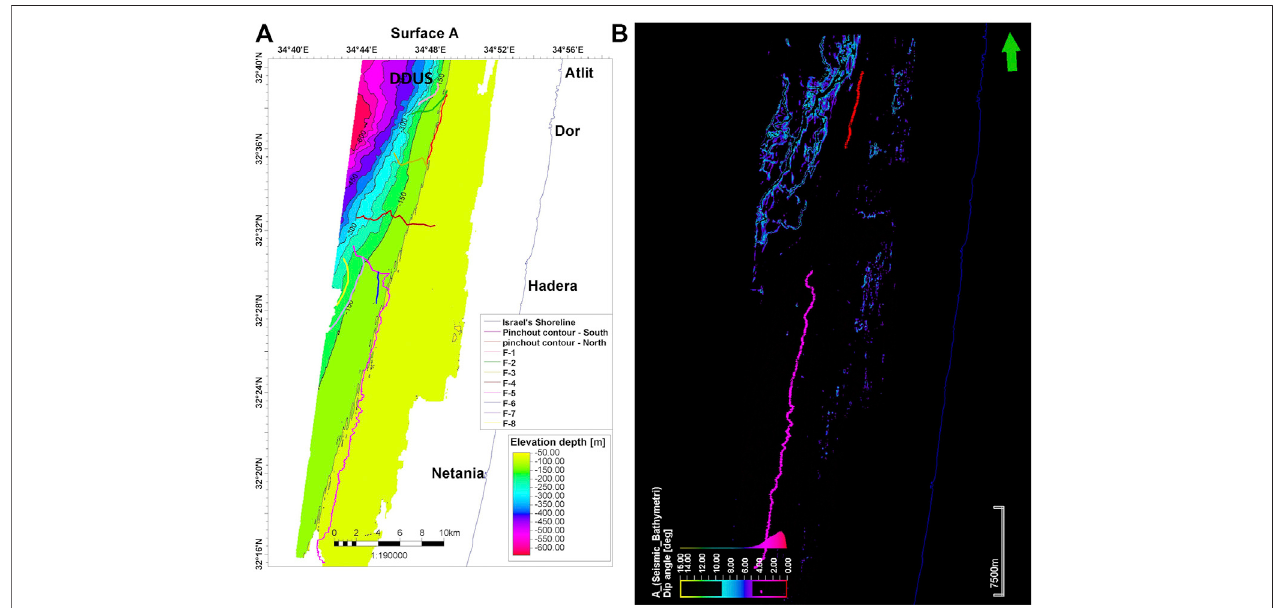
FIGURE 5 | Seismic mapping of Horizon A: (A) Topographic map of Horizon A; (B) Dip angle map of Horizon A.